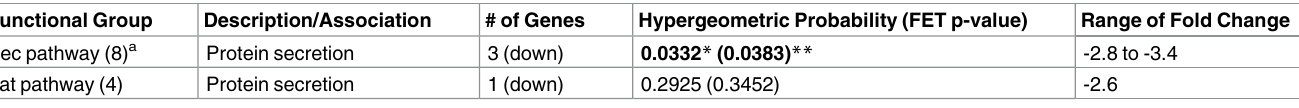
Table 5. Differentially expressedgenes of M . tb sec and tat secretorypathways. Functional Group